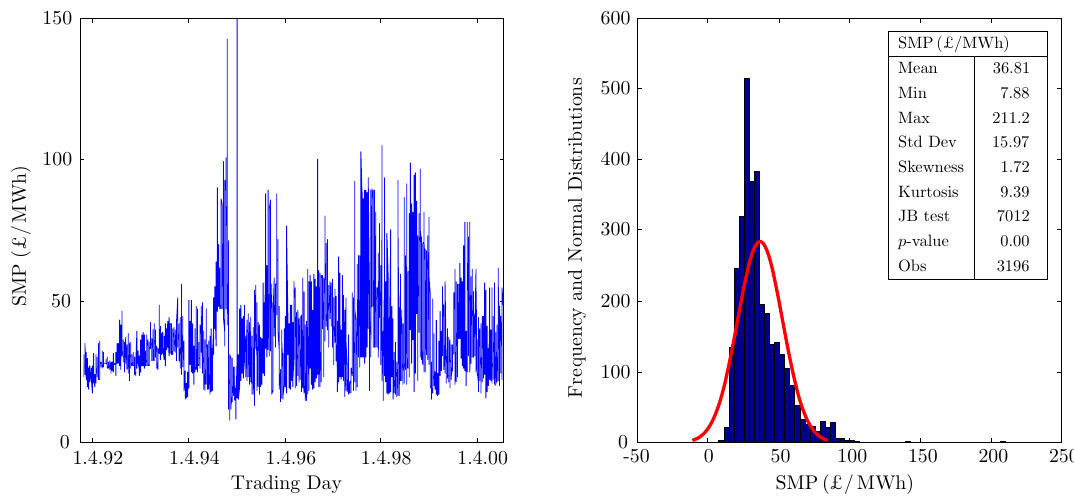
Figure 6. SMP during the peak-demand period over trading days (1 January 1992–30 September